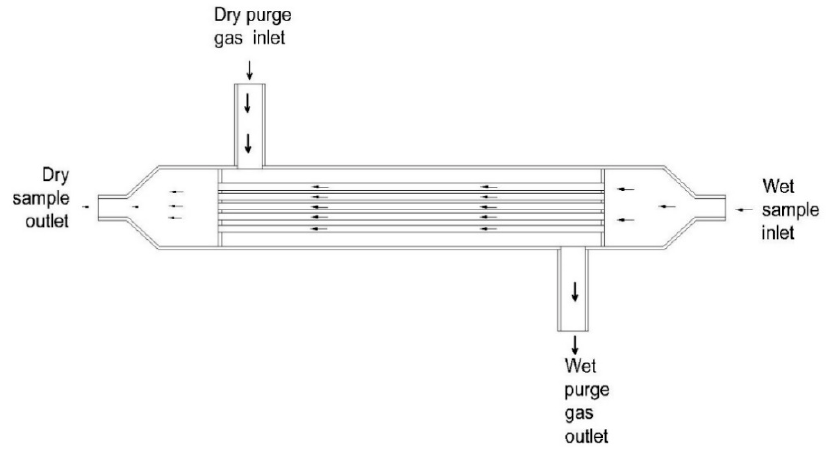
Figure 6. Schematic of a permeation membrane tube [76].